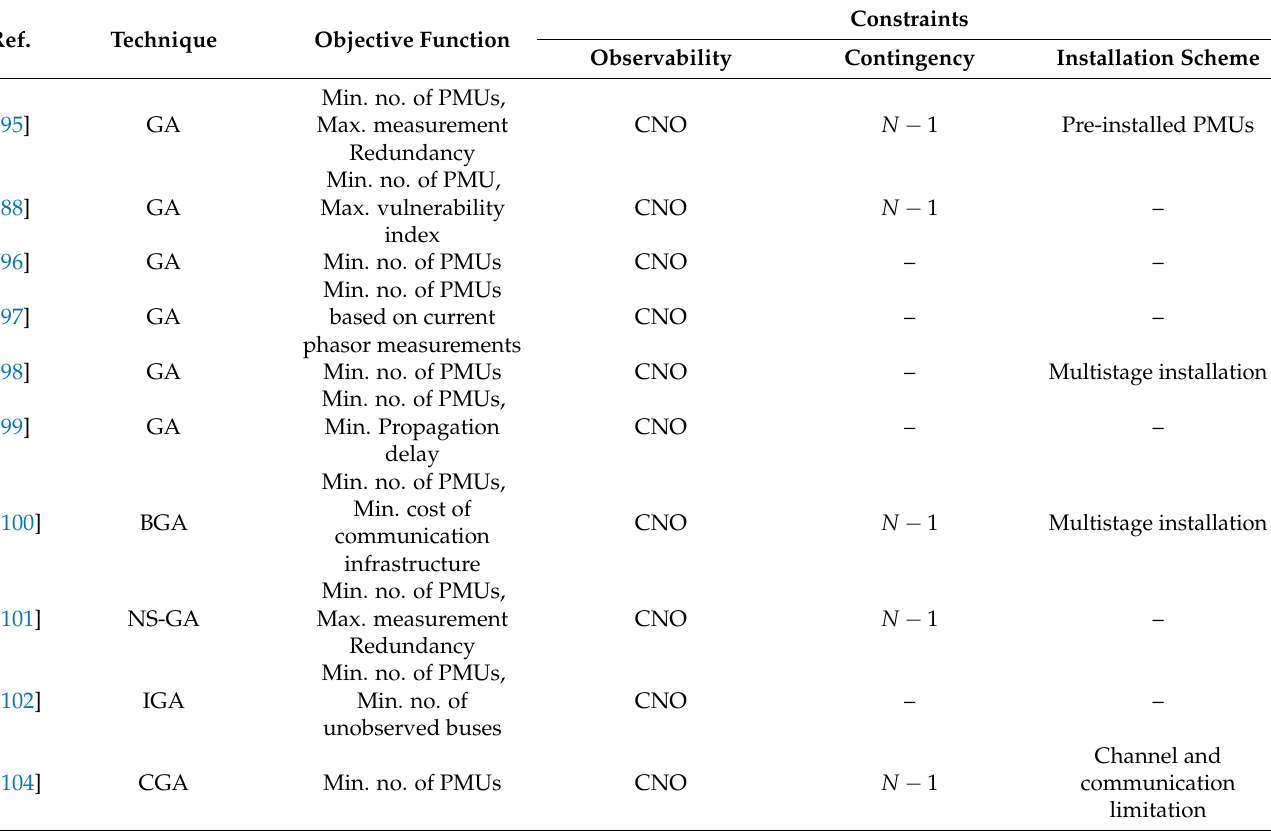
Table 3. A summary of GA based OPP.